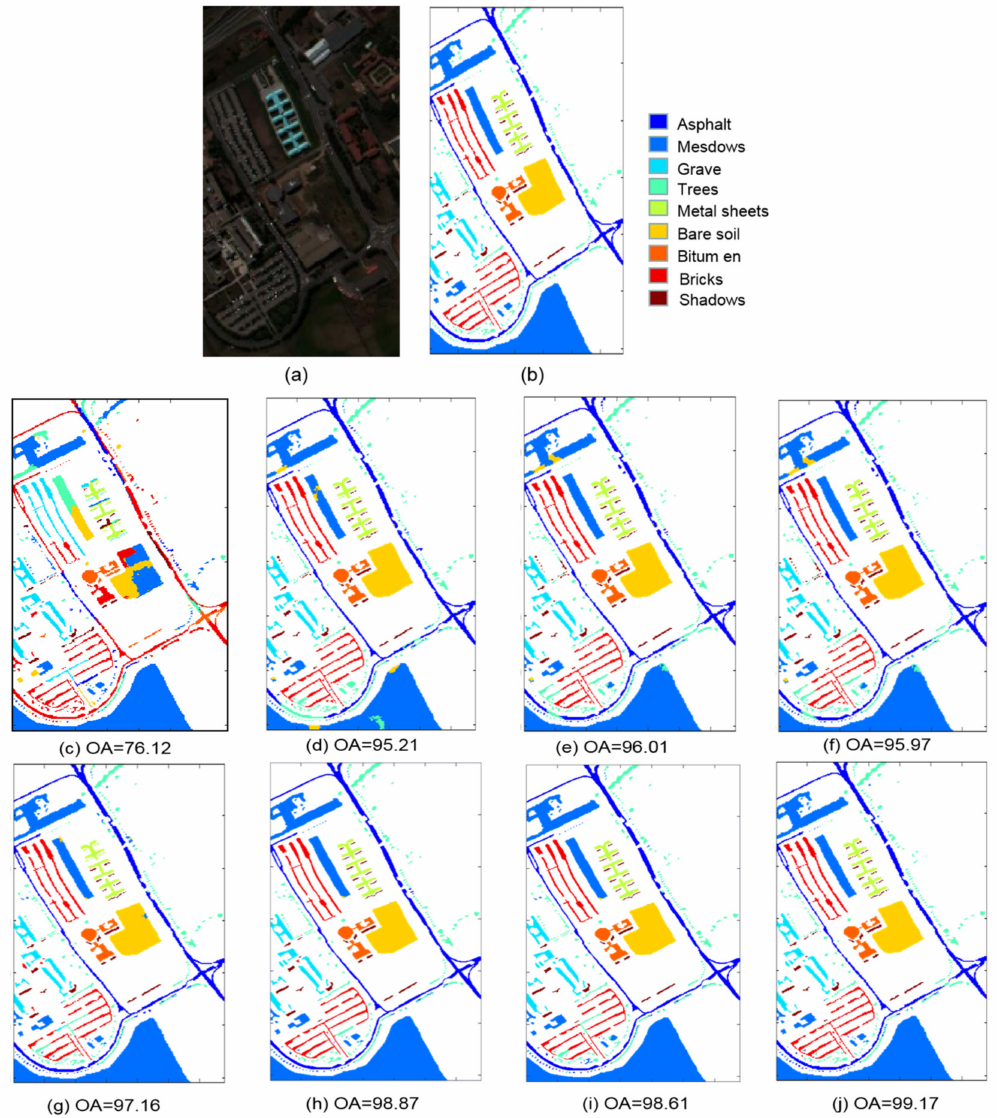
Figure 4. Pavia University image. ( a ) The false-color composite image. ( b ) Ground-truth. The classification maps of ( c ) GCN, ( d ) EPF, ( e ) IFRF, ( f ) SCMK, ( g ) SSL-SL, ( h ) MDGCN, ( i ) SPCNN and ( j ) SSG. Table 4 lists the classification results of various algorithms for Salinas image.